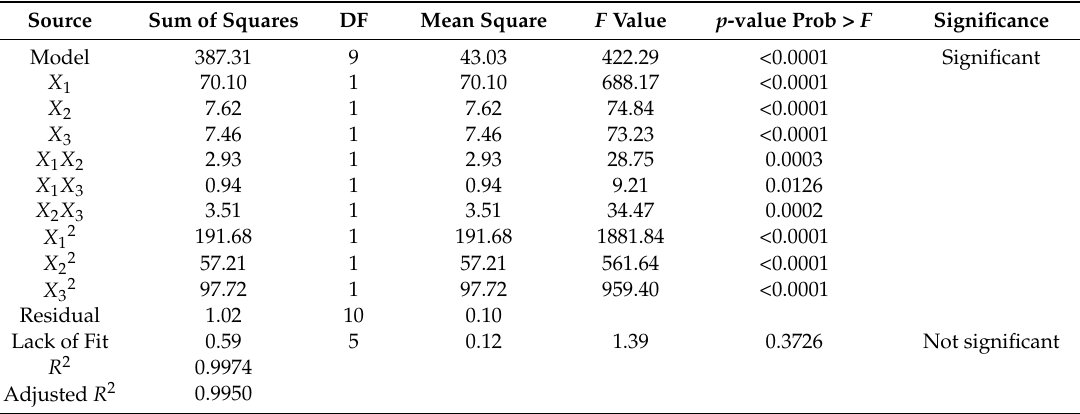
Table 2. ANOVA of the response surface quadratic model for the laccase